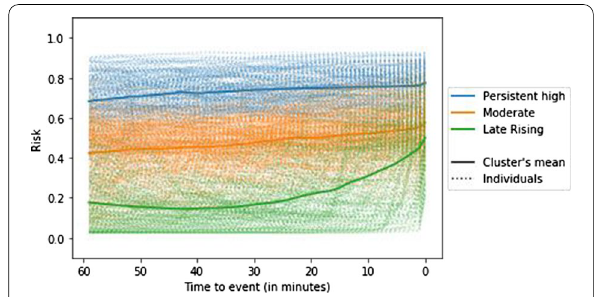
Fig. 1. Phenotypes of risk evolution prior to the first hypotension